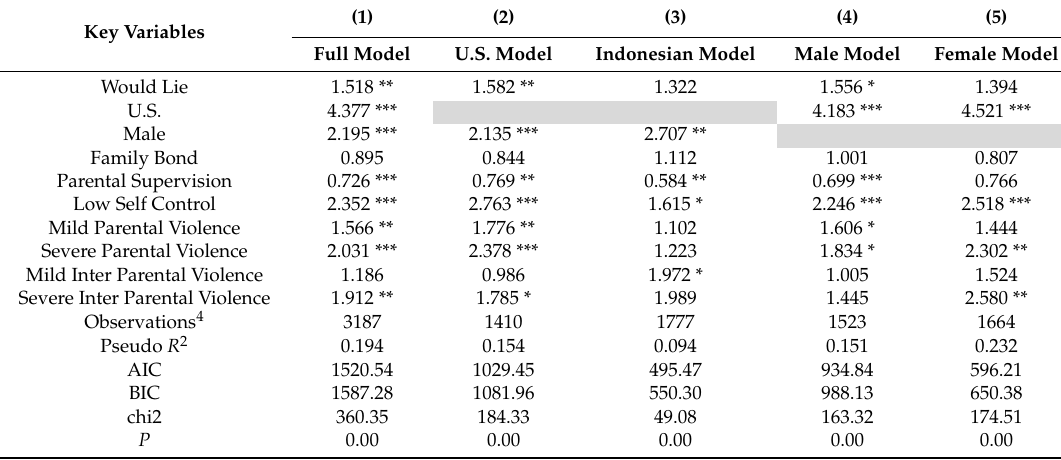
Table 4. Logistic Regression Results: Occurrence of Violent Offending on Key Variables (by Gender and